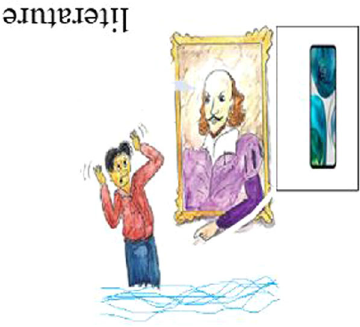
Fig. 6 G3 ’ s adapted visual representation. This fi gure shows how dif fi cult and hazy the literary texts are for EFL